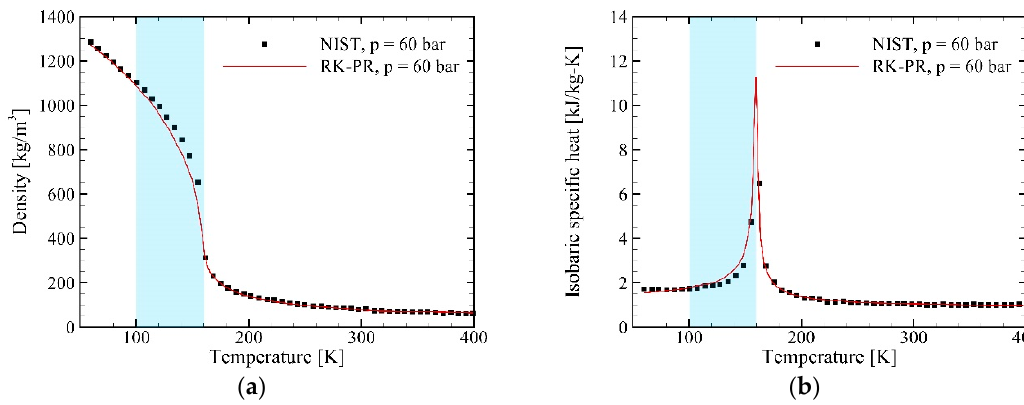
Figure 2. Comparison of thermodynamic properties of RK–PR equation of state to National Institute of Standards and Technology (NIST) data for pure oxygen at 60-bar pressure: ( a ) temperature verses density; ( b ) temperature verses isobaric specific heat.